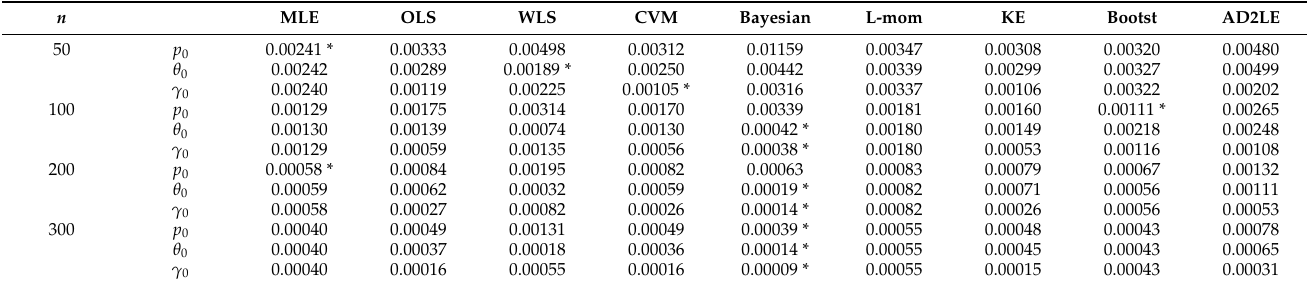
The value with “*” is the best estimation in its row for all estimation methods. Table 6. Results of the MSEs where p = 0.5, γ = 0.3, θ = 0.6.